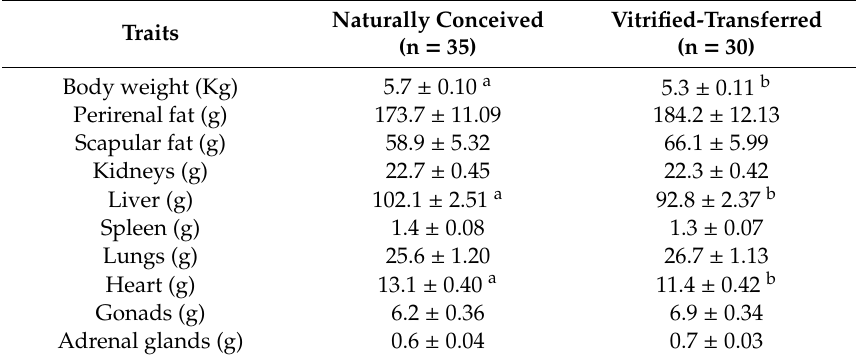
Table 1. Body weight and dissection data of adult, naturally conceived males and those derived from vitrified-transferred